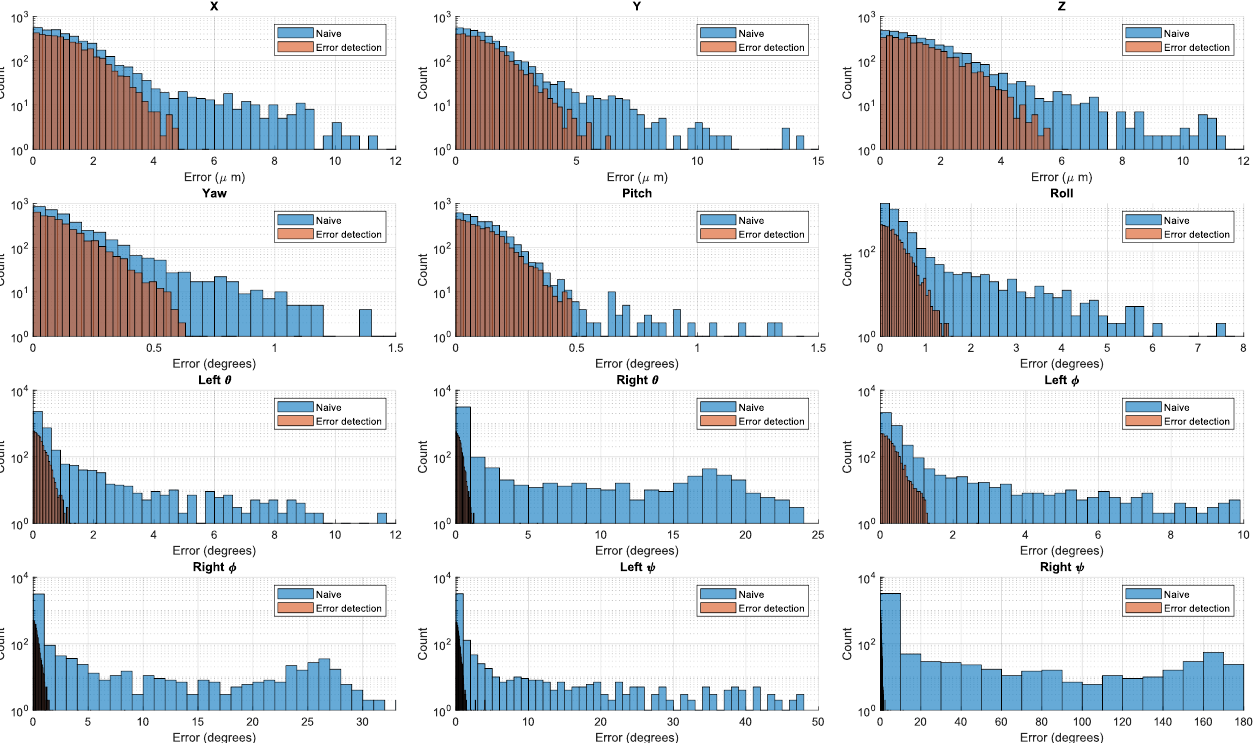
Figure 8. Naive errors vs. error detection. Each graph is a histogram of the errors for each DOF. The blue bars are the naive optimization process and the orange bars are the process using error